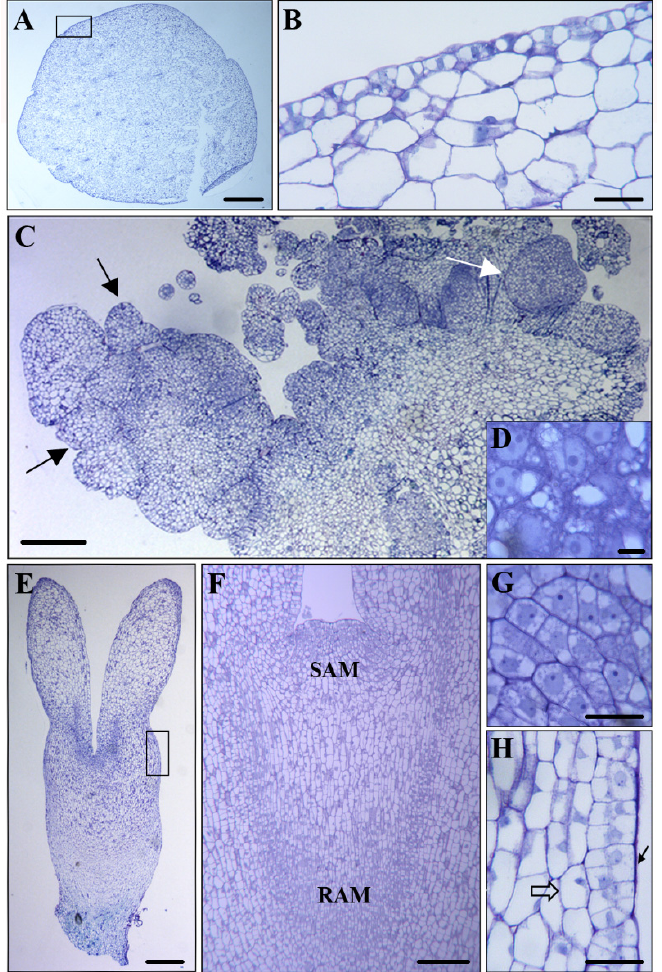
Figure 2. Cellular organization of main stages of somatic embryogenesis. Micrographs of semithin sections stained by Toluidine blue. ( A , C , E ) Panoramic view of immature zygotic embryo, ( A ) cluster of proembryogenic masses, and ( C ) torpedo embryo ( E ). ( B , D , F , G , H ) Detail of representative regions at higher magnification. ( B ) Epidermis of immature zygotic embryos, as indicated by the square in ( A